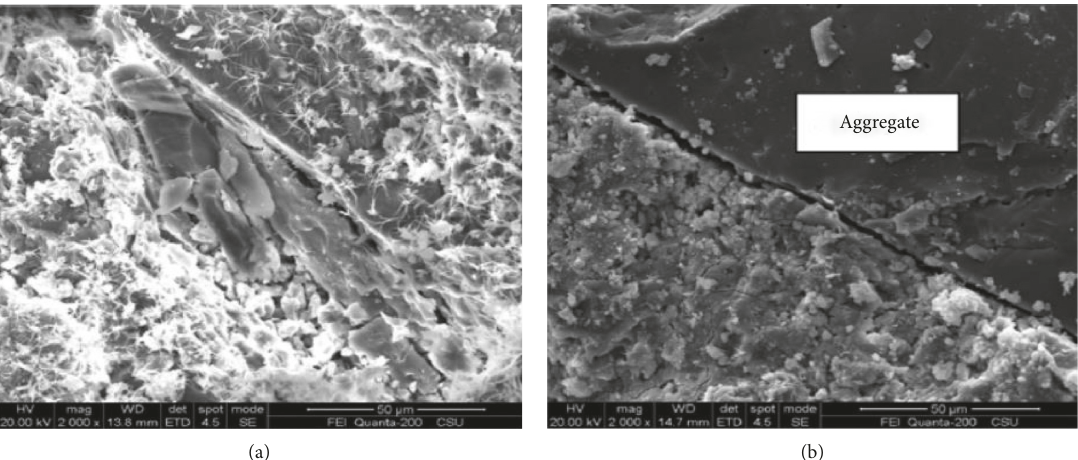
Figure 14: SEM images of old mortar and ITZ of RA with and without carbonation [183]. (a) RA and (b) RA after carbonation.